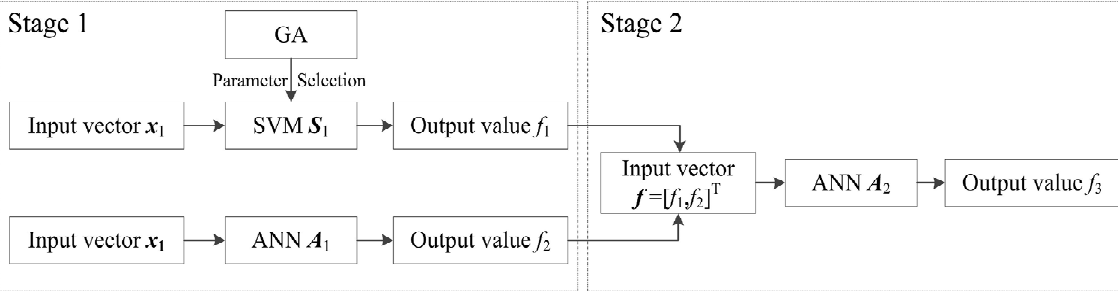
Figure 5. Sketch map of the hybrid